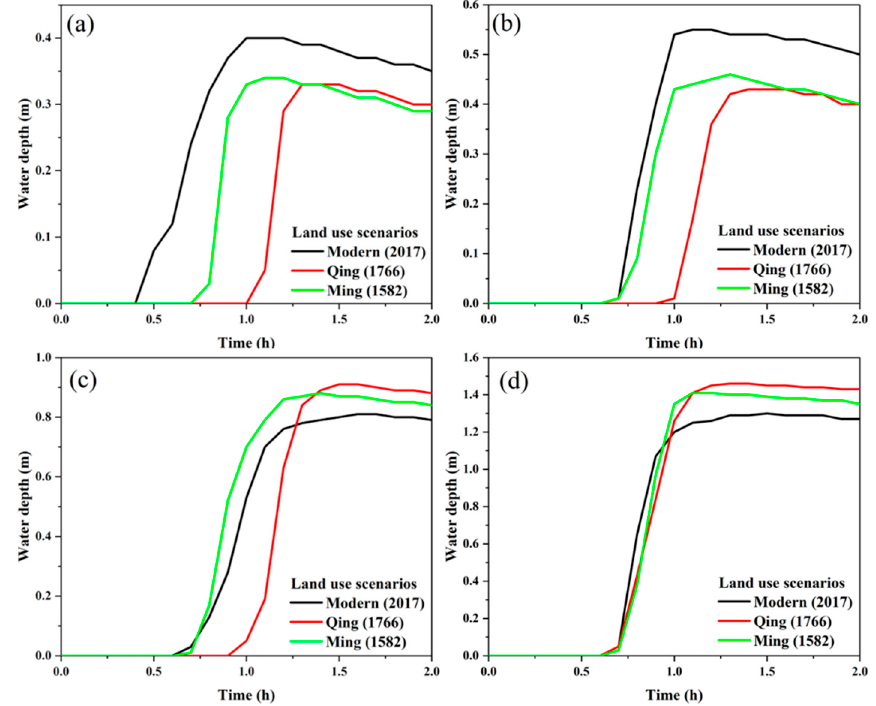
Figure 10. Variation process of the inundation depth of the maximum water accumulation point in ( a ) 10-year recurrence period; ( b ) 20-year recurrence period; ( c ) 50-year recurrence period; ( d ) 100-year recurrence period.